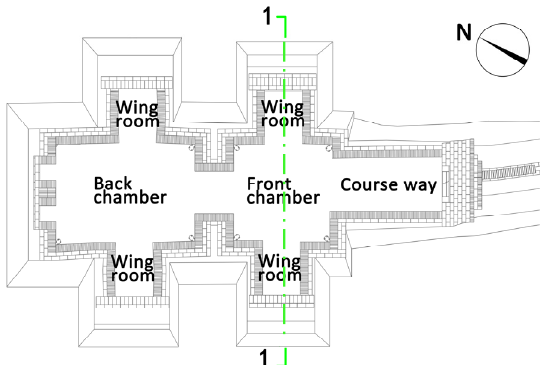
Figure 2. Plan of the Eastern Wu tomb.